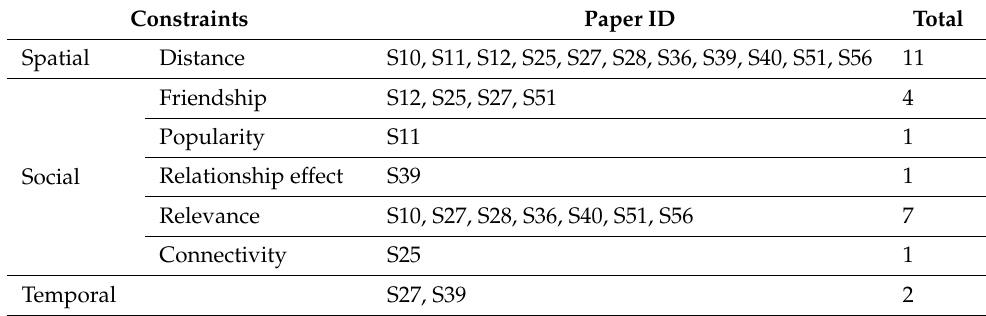
Table 11. Main types of spatial, social, and temporal constraints applied in geosocial top-k queries. Constraints